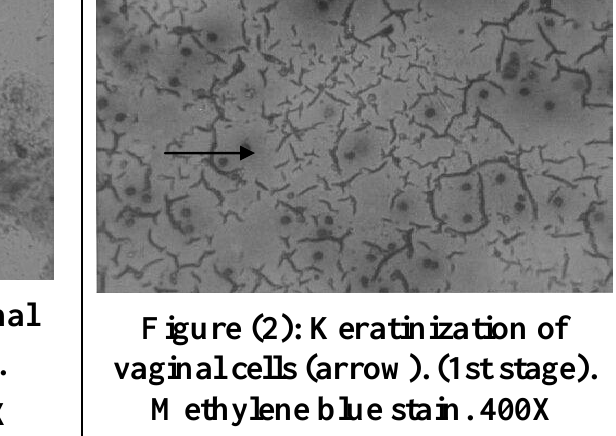
Figure (1): Polyhedral vaginal epithelial cells . (2 nd stage). Methylene blue stain. 400X